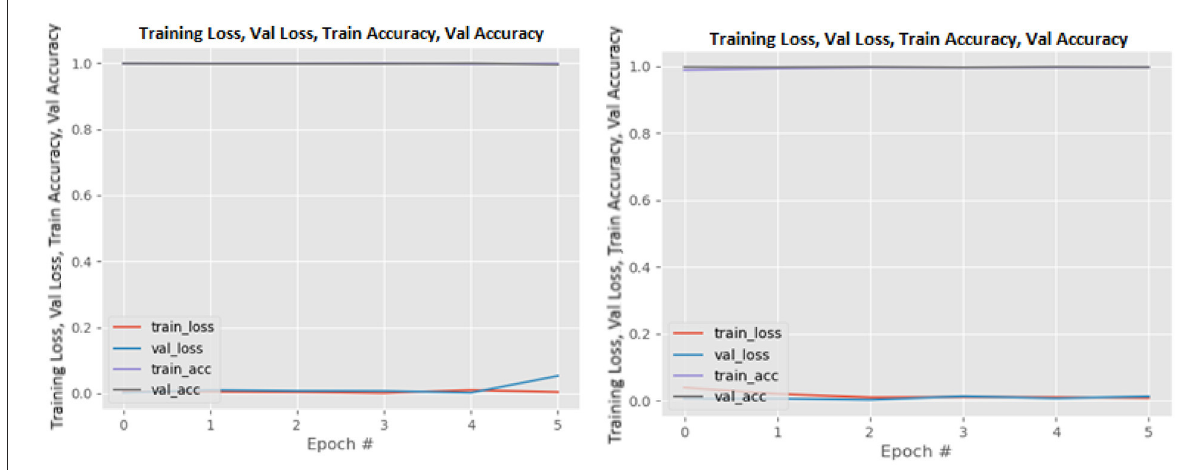
FIGURE11 InceptionResNetV2 without data augmentation (left image) and with data augmentation (right image).